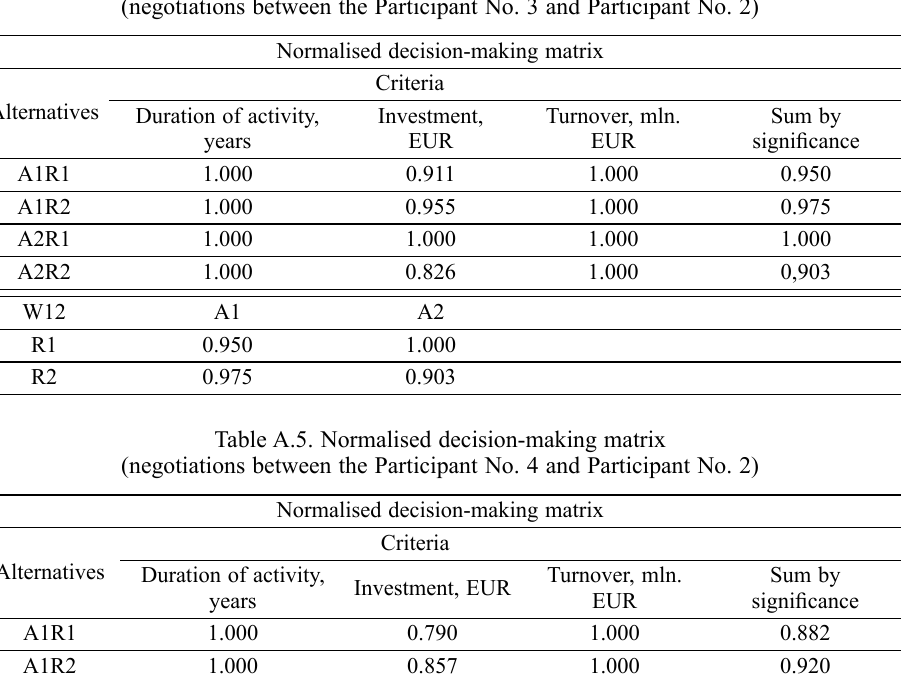
Table A.4. Normalised decision-making matrix (negotiations between the Participant No. 3 and Participant No. 2)